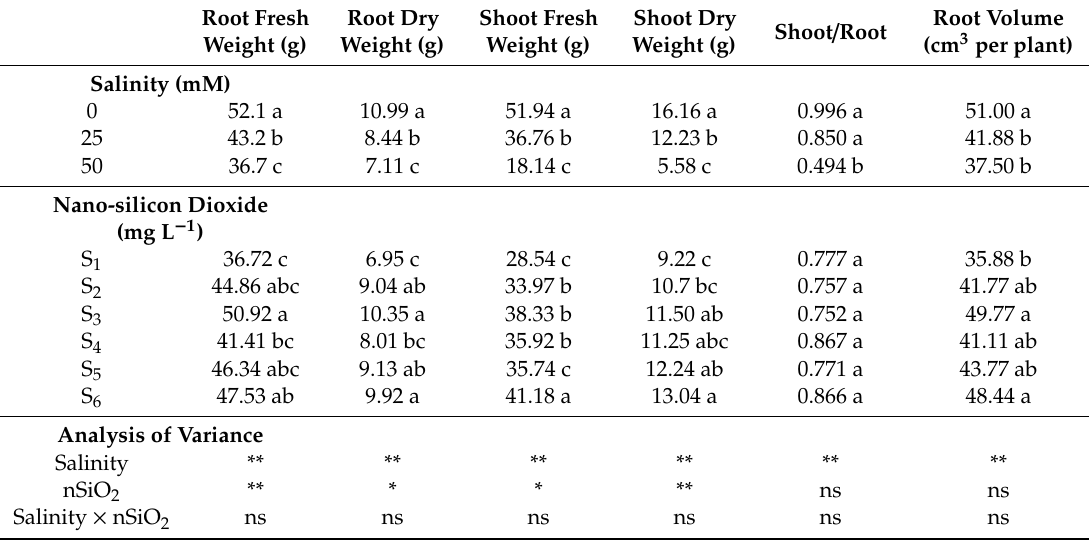
Table 2. E ff ect of nSiO 2 and salt stress on biomass parameters, root and shoot dry weight and fresh weight of strawberry cv “Camarosa”, including analysis of variance. Root Root Fresh Root Dry Shoot Fresh Shoot Dry Shoot / Root Weight (g) Weight (g) Weight (g) Weight (g)